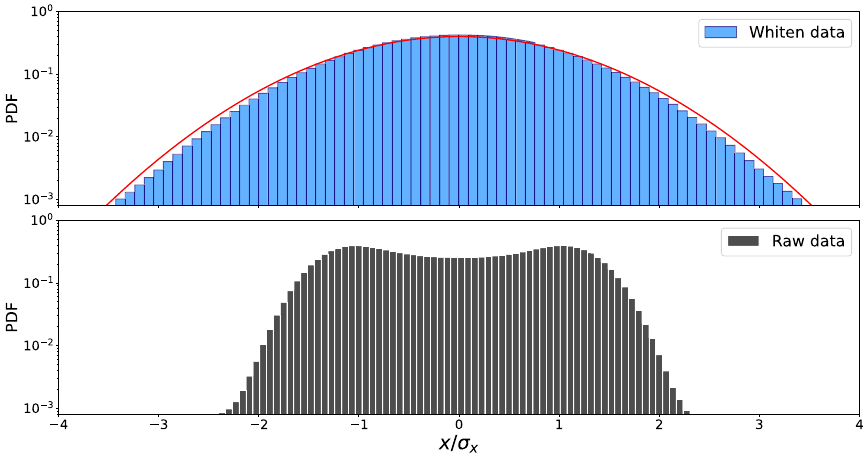
Figure 5. Probability distribution functions of normalized background and its whitened noises before the event 29 July 2017. In lower panel, probability distribution functions (PDF) of normalized background noise x ( t ) ≡ x ( t )/σ x estimated from ∼ 3 × 10 4 data points is plotted in log-linear scale. In upper panel, the PDF of its whitened time series is depicted which has a Gaussian.